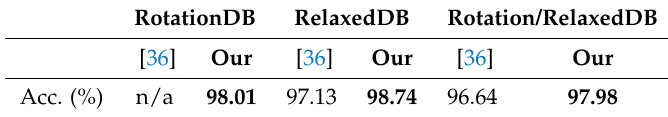
Table 7. Comparison to the state-of-the-art research work of